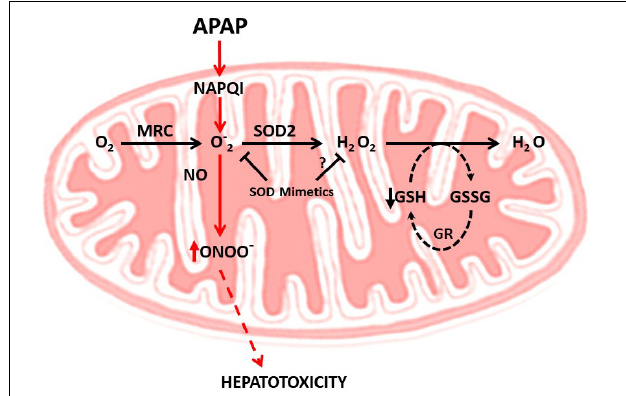
FIGURE 2 | Mitochondrial oxidative and nitrosative stress in APAP hepatotoxicity. APAP metabolism results in NAPQI generation, which induces superoxide anion generation within the mitochondrial respiratory chain (MRC). The combination of superoxide anion with nitric oxide (NO) generates peroxynitrite (ONOO - ), a free radical which induces nitrosative stress and cell death. The scavenging of superoxide anion by SOD2 decreases ONOO - generation, suggesting the use of SOD mimetics to ameliorate APAP hepatotoxicity. The specificity of SOD mimetics in scavenging superoxide anion vs. hydrogen peroxide may determine protection against APAP hepatotoxicty, particularly in the face of mGSH depletion. In this scenario of decreased mGSH levels superoxide anion scavenging may result secondarily in increased hydrogen peroxide formation, which can lead to enhanced hepatocellular cell death, as reported in the context of non-alcoholic steatohepatitis. Whether this is the case in APAP hepatotoxicity remains to be determined. FIGURE 3 | Two hit model during APAP-induced hepatotoxicity. The first hit